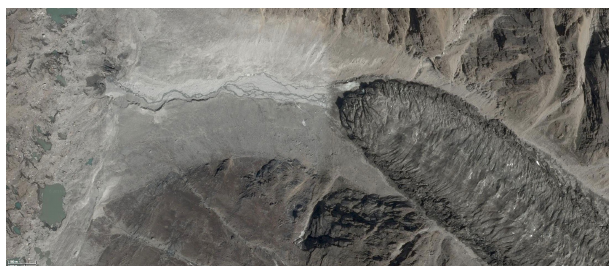
Figure 6. The still-advancing (surging) tongue of First Feriole Glacier in the Panmah subregion. The image is a screenshot from Google Maps and was acquired on 6 June 2014.